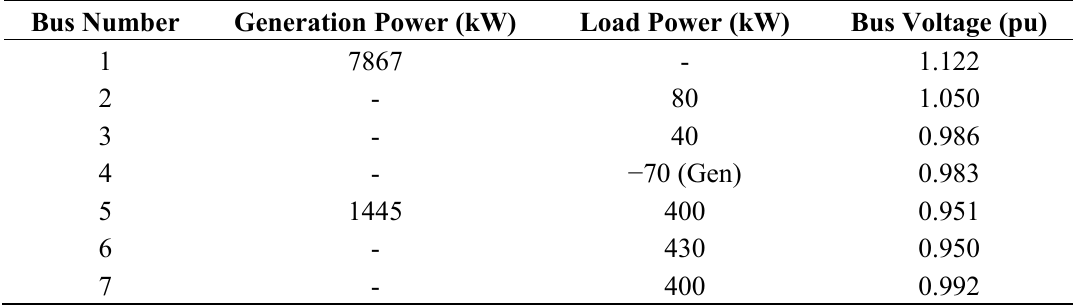
Table 3. Results of the algorithm when the DG is located at Bus 5.